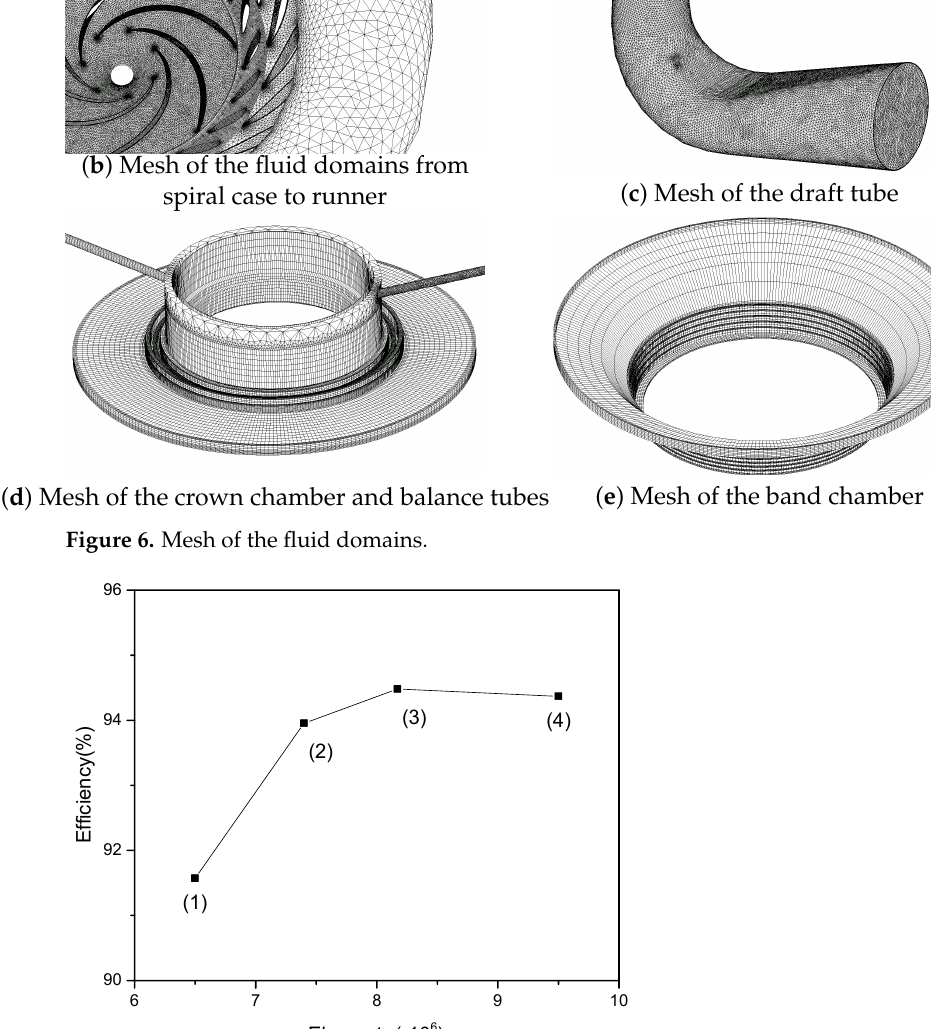
Figure 7. Mesh independence analysis using four sets of meshes with different element